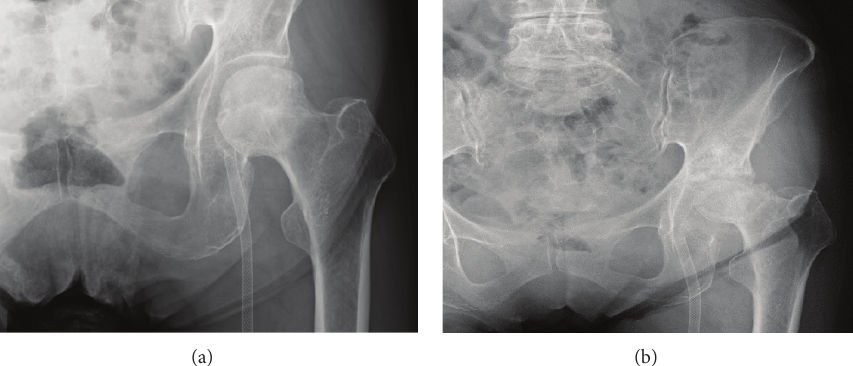
Figure 1: Plain radiography. (a) Just after the stent placement in another hospital. Stent is detained in left femoral artery. Left femoral head was not collapsed. (b) At the time of admission to our hospital. Left femoral head was collapsed and joint space disappeared.